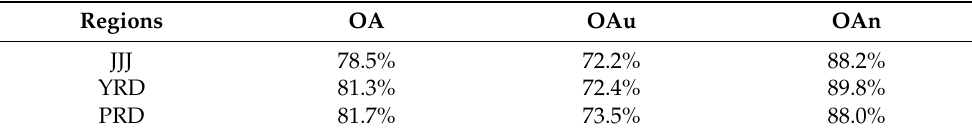
Table 3. The classification accuracies in three urban agglomerations. Regions OA